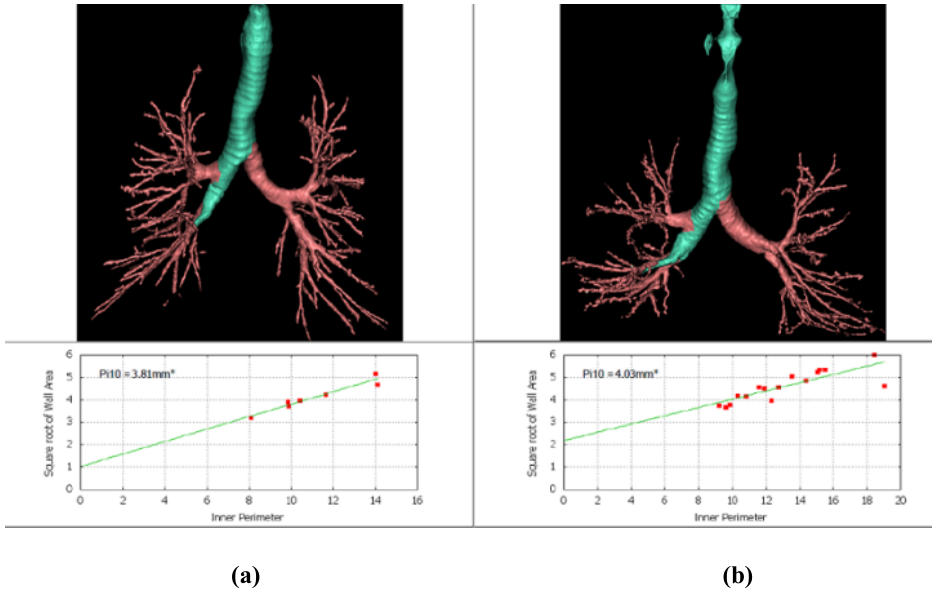
Figure 2. Quantitative data of Pi10 in the right middle lobe in two patients: ( A ) A 78-year-old male in the moderate smoker group (Pi10 = 3.81 mm 2 ) and ( B ) an 82-year-old male in the heavy smoker group (Pi10 = 4.03 mm 2 ).